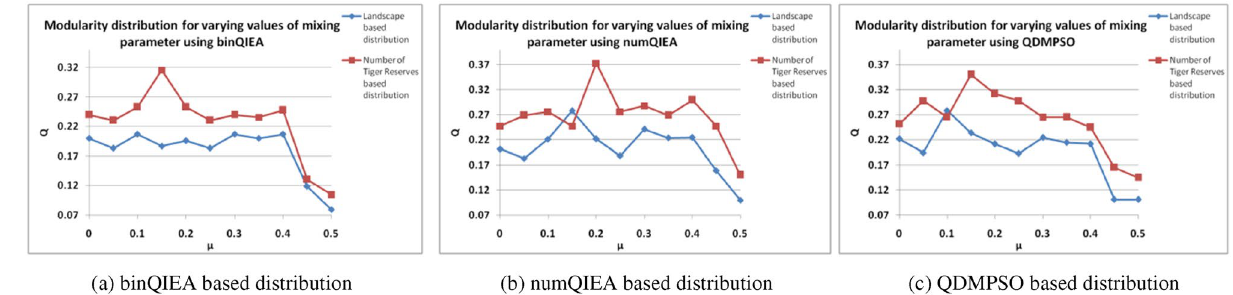
Figure 4. Comparative modularity (Q) based distribution of QIML approaches for varying values of mixing parameter (µ) for two novel